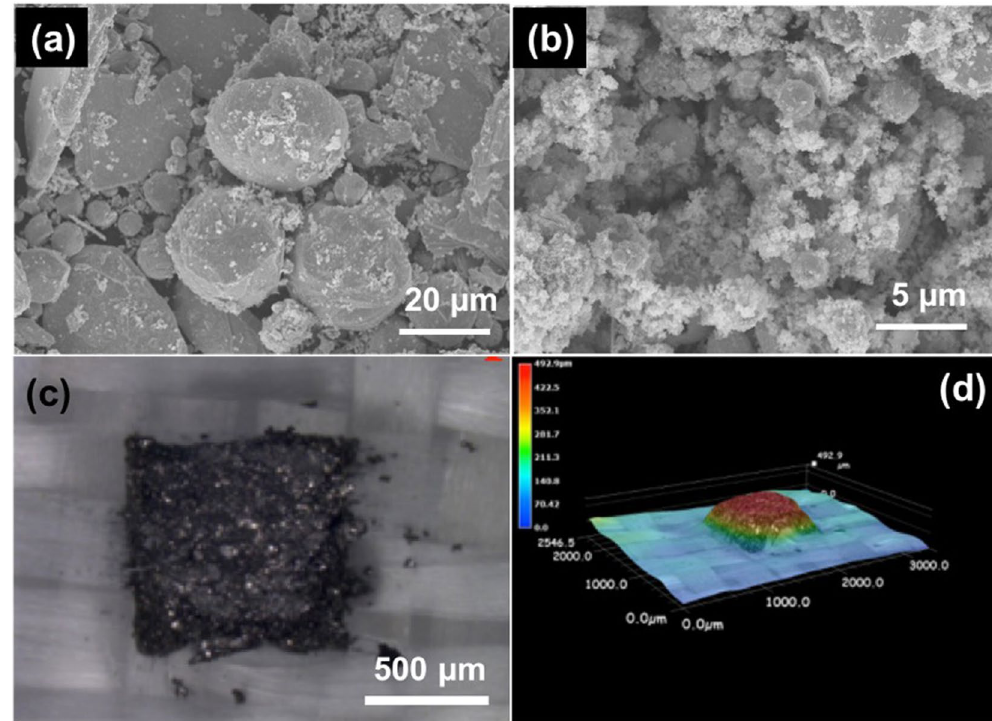
Figure 2. SEM images of particles with ( a ) large ( > 20 µ m) and ( b ) small diameter ( ≪ 1 µ m). Optical images of ( c ) printed thick thermoelectric ink for high aspect ratio TE pillars before the hot-pressing process, with 1 mm 2